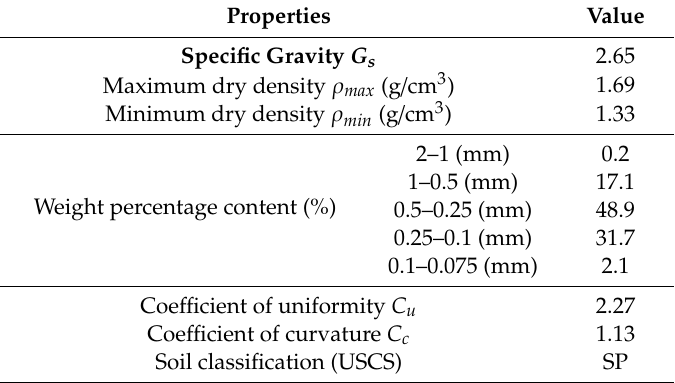
Figure 1. The used sand in this study: ( a ) macro and ( b ) micro. Table 1. The physical parameters of the sand used in this study.